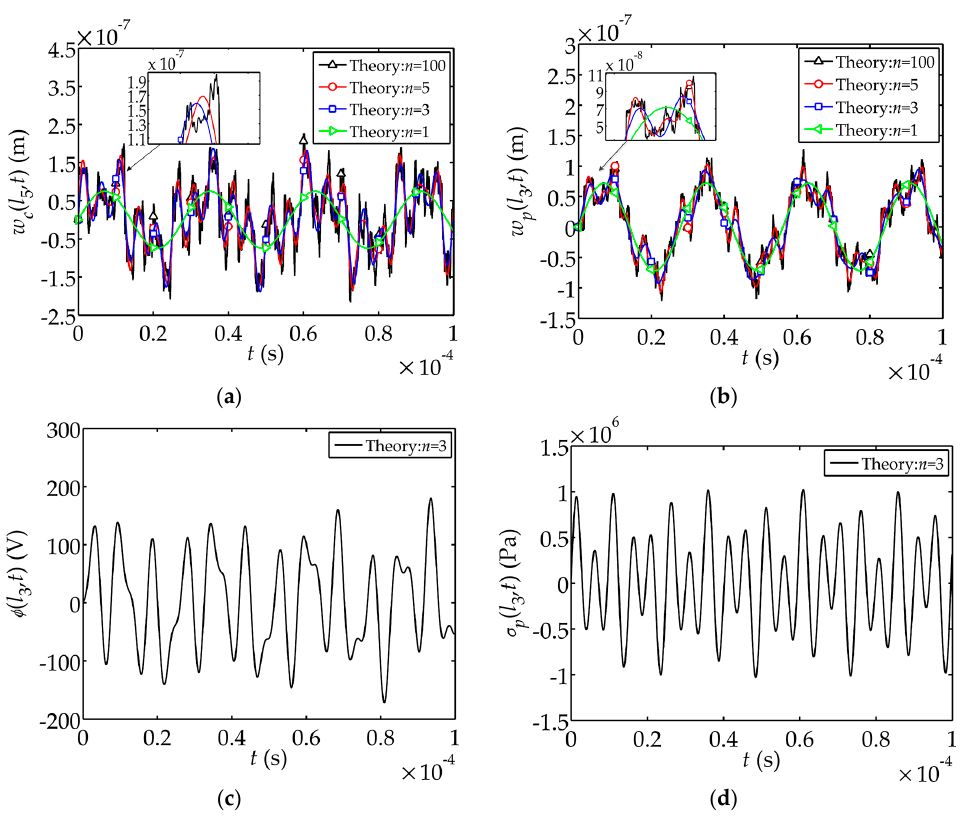
Figure 3. Theoretical solution of displacement, electric potential and stress: ( a ) Displacement w c ( l 5 , t ); ( b ) Displacement w p ( l 3 , t ); ( c ) Electric potential ϕ ( l 3 , t ); ( d ) Stress (cid:2026) (cid:3043) ( l 3 , t ).